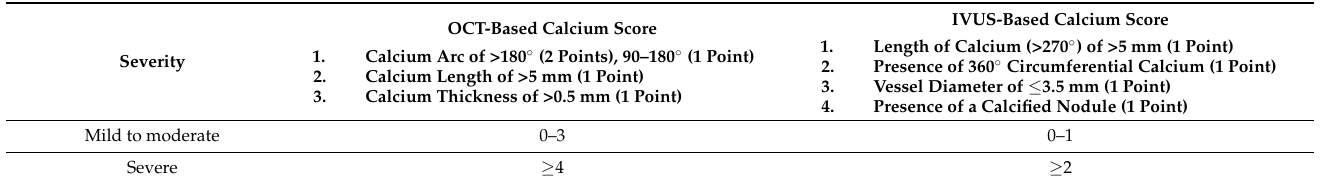
Table 2. Classification of calcified coronary lesion severity based on intravascular